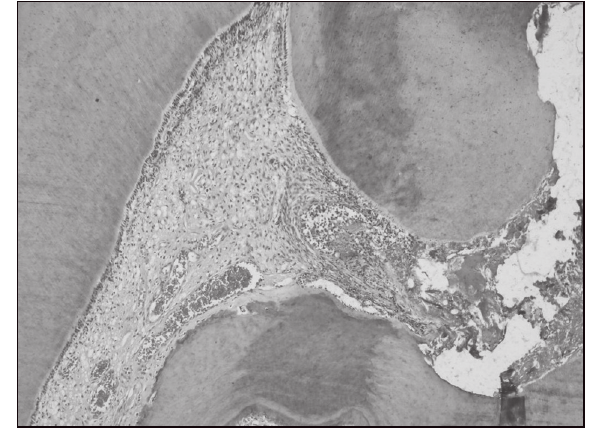
Figure 4 - Photomicrograph of a rat tooth 7 days after pulpotomy and pulp capping with calcium hydroxide show- ing light inflammatory infiltrate (HE, 100 × ).